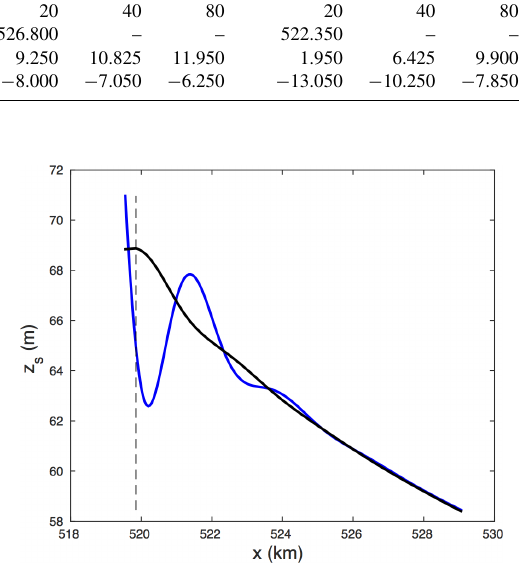
Figure 4. Grounding-line position vs. local floatation. The vertical black dashed line marks the equilibrium GL position for the Stnd experiment and the heavy blue and black lines denote the mod- eled ice sheet surface near the GL (blue) vs. that determined by the floatation condition (black) (compare with the inset in Fig. 2b from Durand et al.,